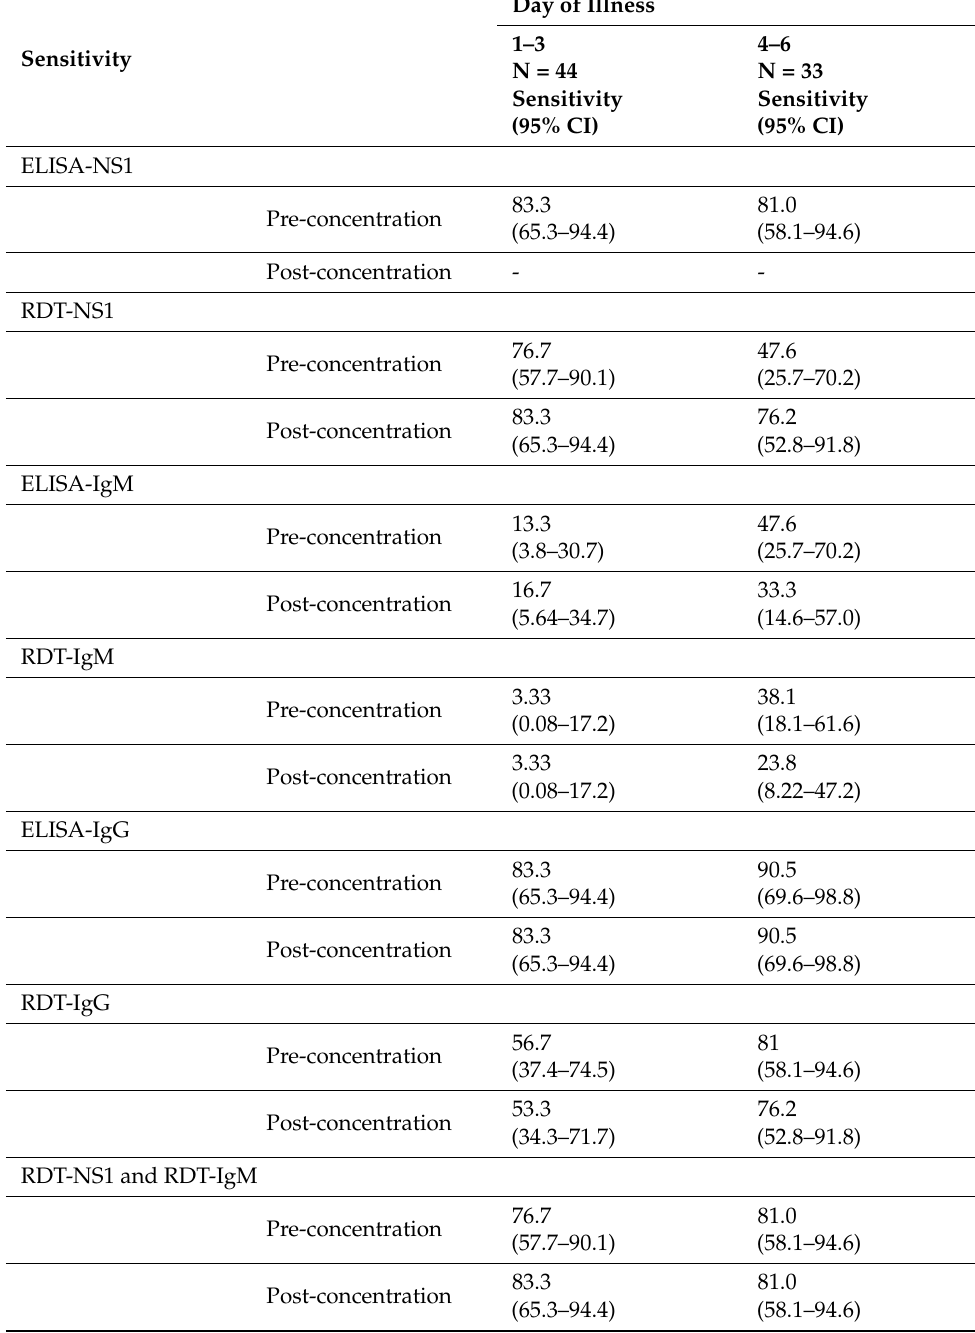
Table 3. Sensitivity of different dengue diagnostic methods by day of